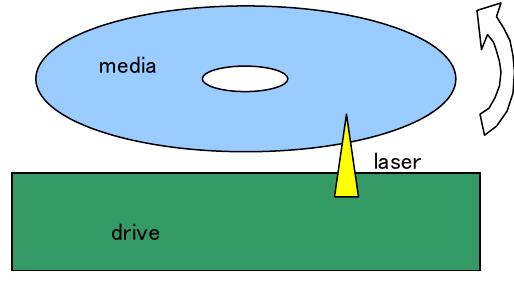
Figure 5. System of optical